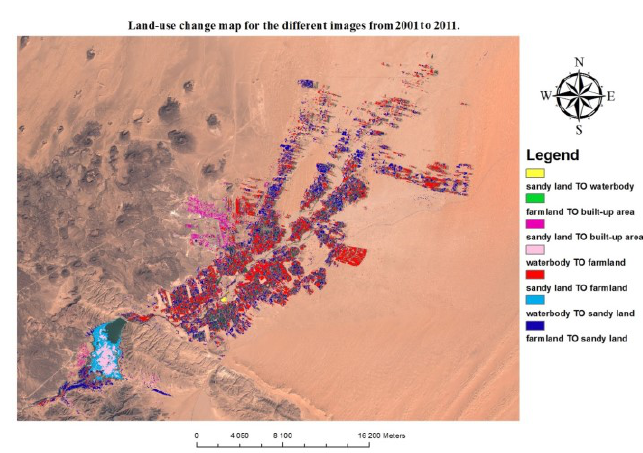
Fig.7. Geospatial distribution of LULC changes between 1987 and